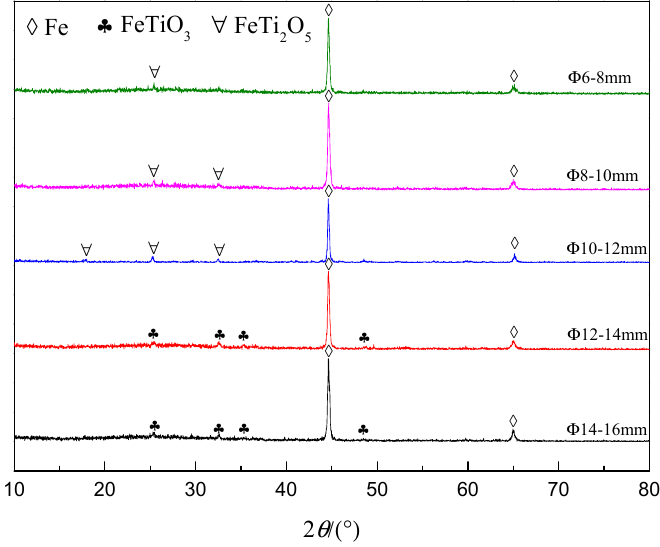
Figure 11. The reduction degree curves of oxidized VTM pellets at 1273 K with different oxidized VTM pellets diameter in H 2 /(H 2 + CO) = 1/2 atmosphere.